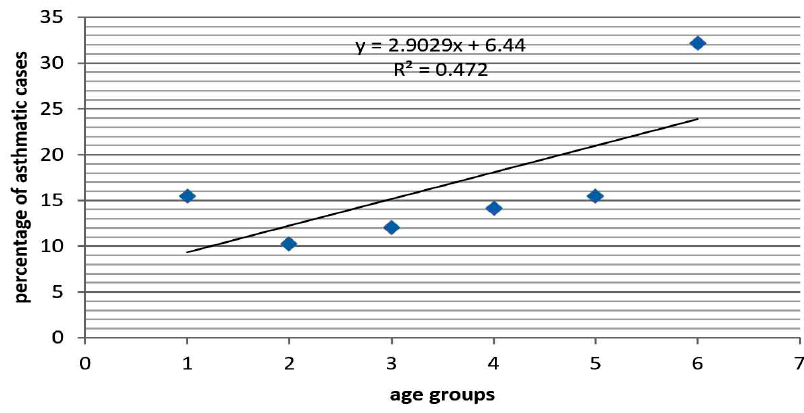
Fig 5. Simple linear regression between age groups and the percentage of patients having